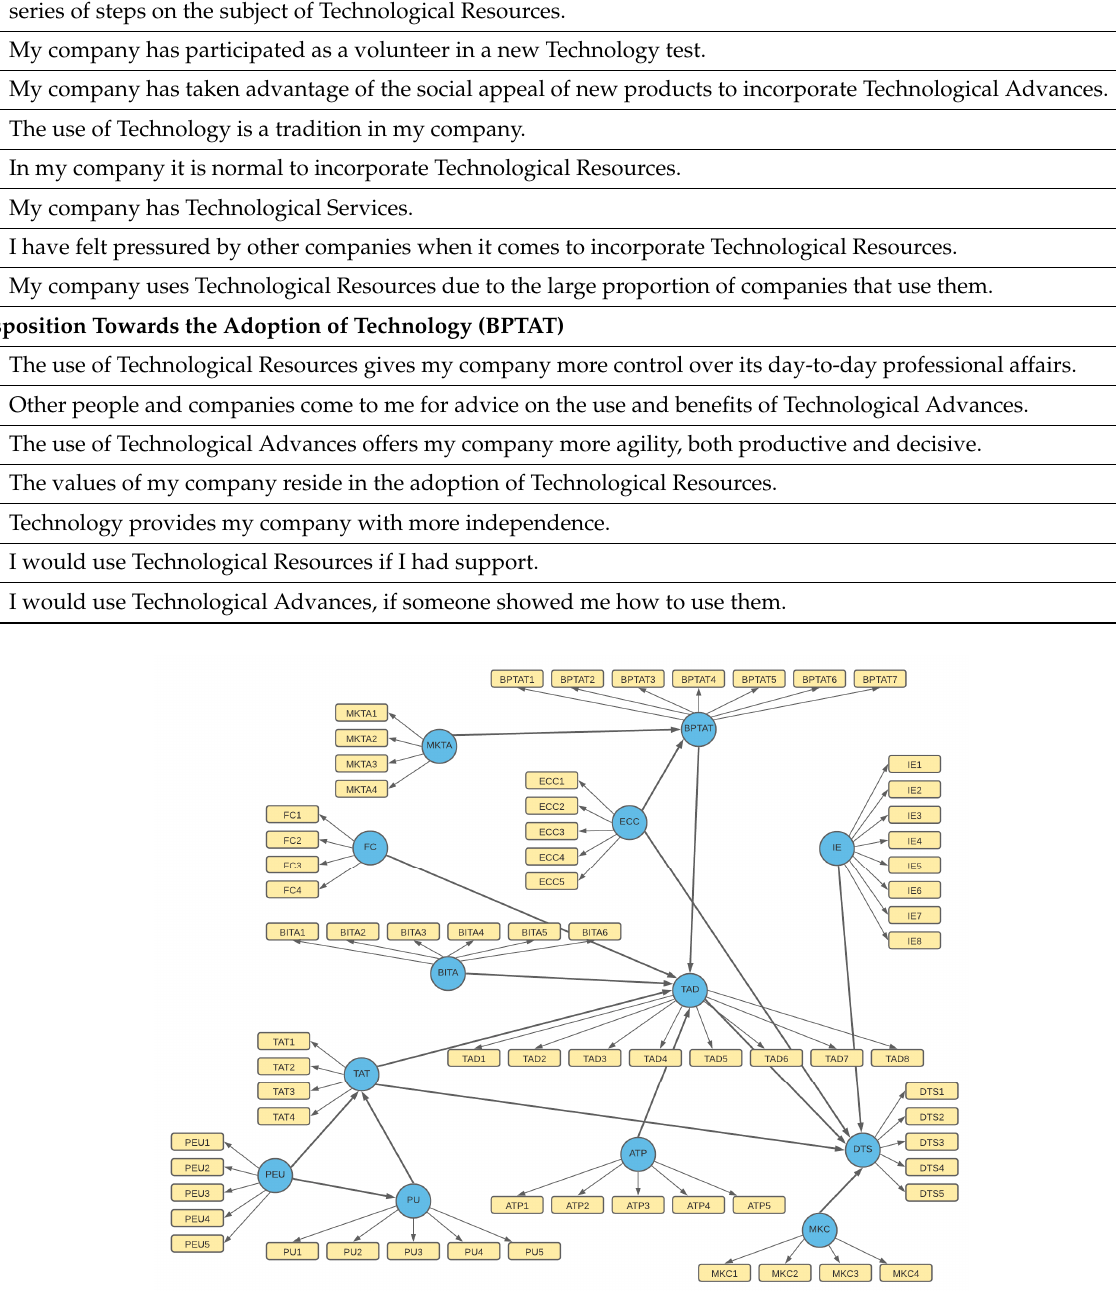
Figure 6. Initial theoretical model. Table 1. Constructs and indicators of the measurement models.